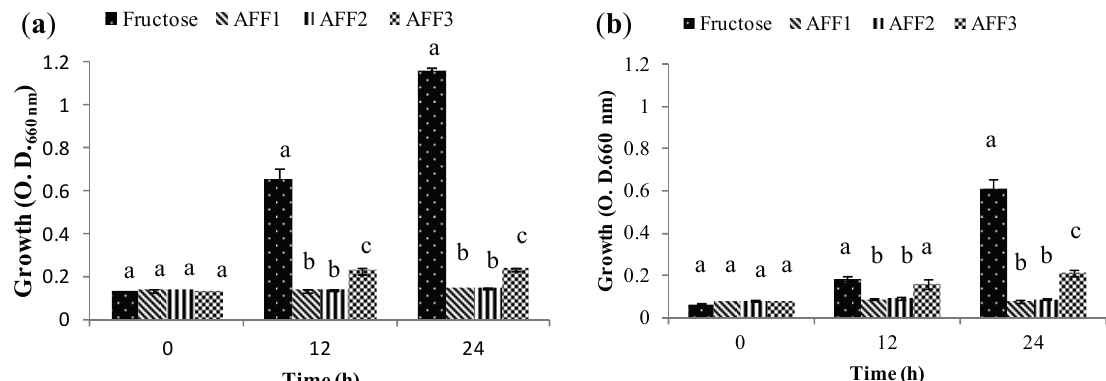
Figure 4. Growth (O.D.) of probiotic bacteria in Group 1 (G1) at 0, 12 and 24 h in semi-synthetic medium using AFF1, AFF2, AFF3 as the sole carbon source and fructose as fermentation control. ( a ) Lactobacillus casei subsp. rhamnosus ATCC 9595. ( b ) Lactobacillus plantarum 299